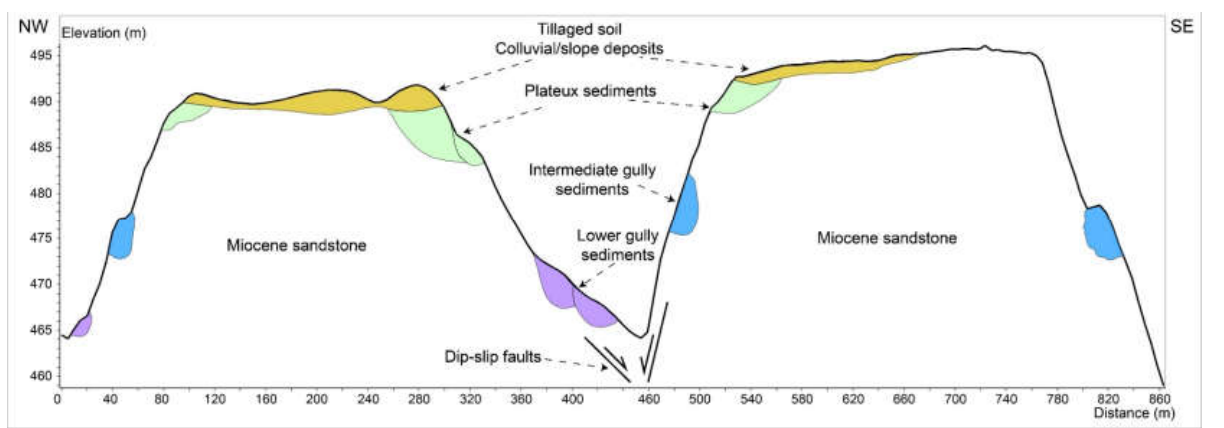
Figure 4. Morphological expressions of gullies-plateaux with observed sedimentation locations.